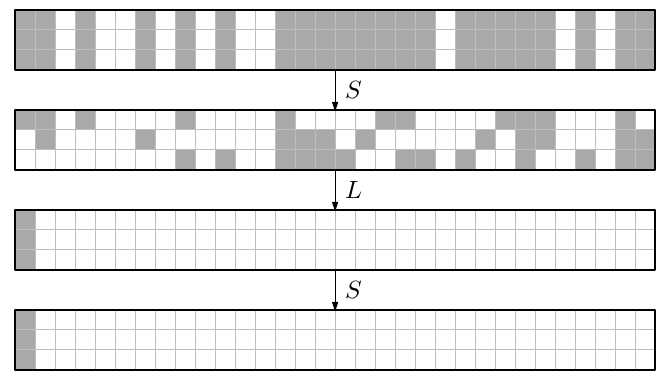
Figure 6: Information needed to compute the output bits of one S-box after 1.5